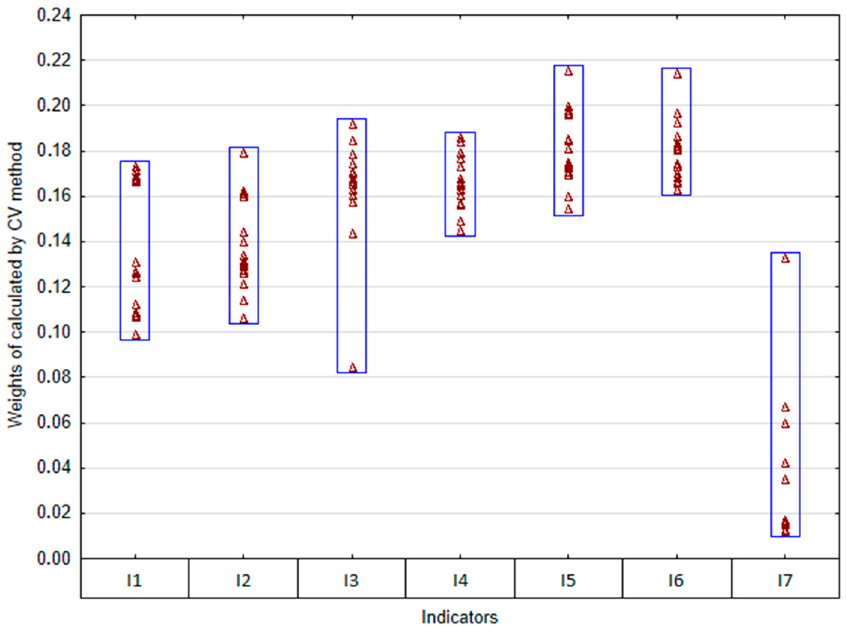
Figure 1. Weights of used indicators calculated with the use of CV method.